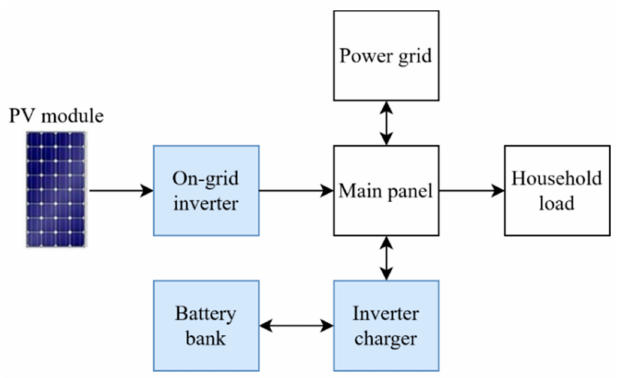
Figure 2. Alternative 1, configuration for microgrids of a residential household.